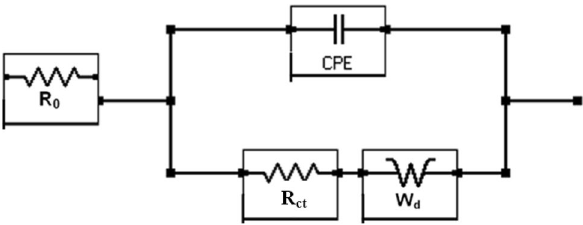
Figure 18. Equivalent electrical circuit of the CPE simplex model incorporating the CPE and the Warburg diffusion component (W); R ct and R s represent the charge transfer resistance and solution resistance, respectively.